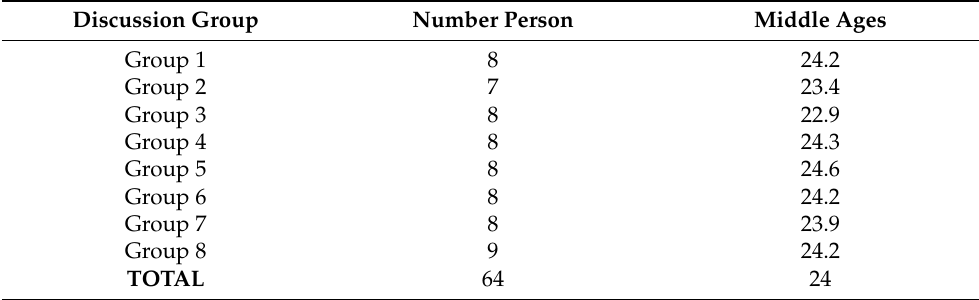
Table 1. The mean age of the discussion groups. Authors’ own elaboration. Discussion